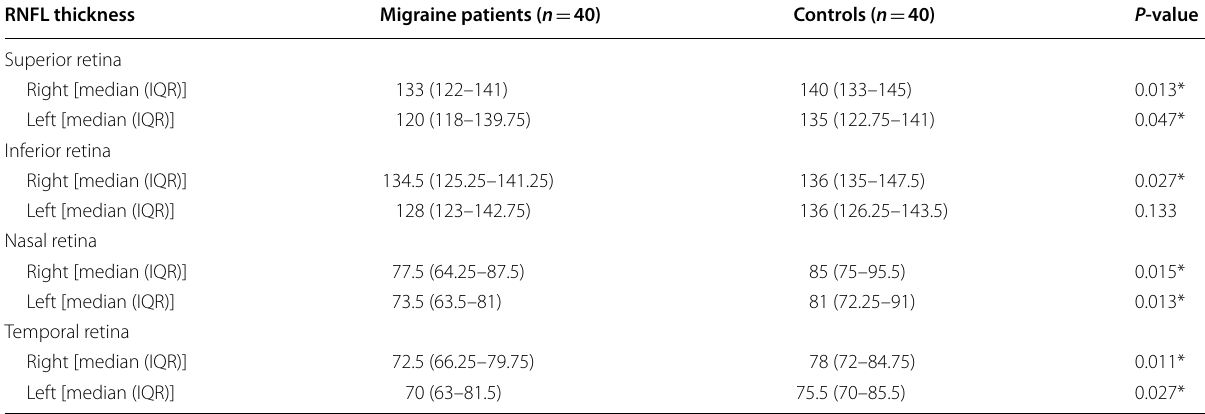
Table 2 Retinal nerve fiber thickness layer in migraine patients in comparison to controls